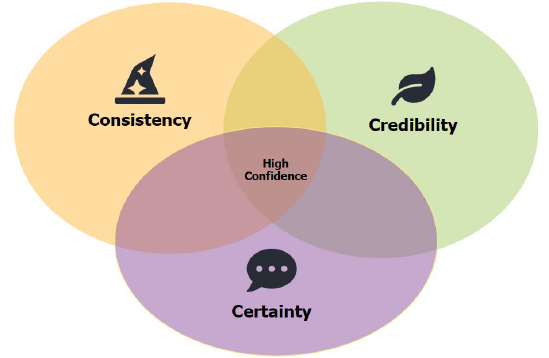
Figure 4. Intergrated